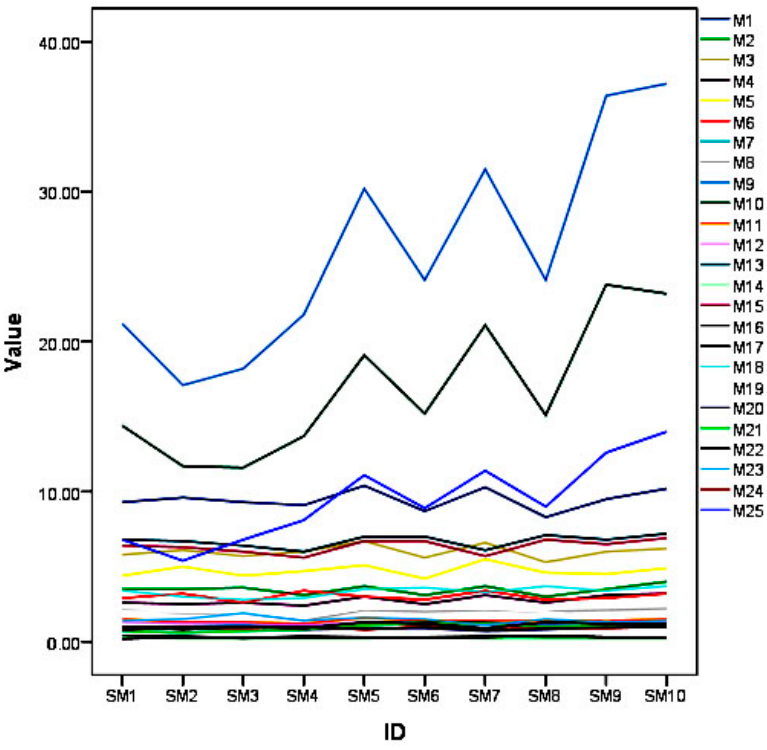
Figure 1. A diagram showing line graphs of each anatomical measurements of the 10 skulls and mandibles (SM) of the common opossum.